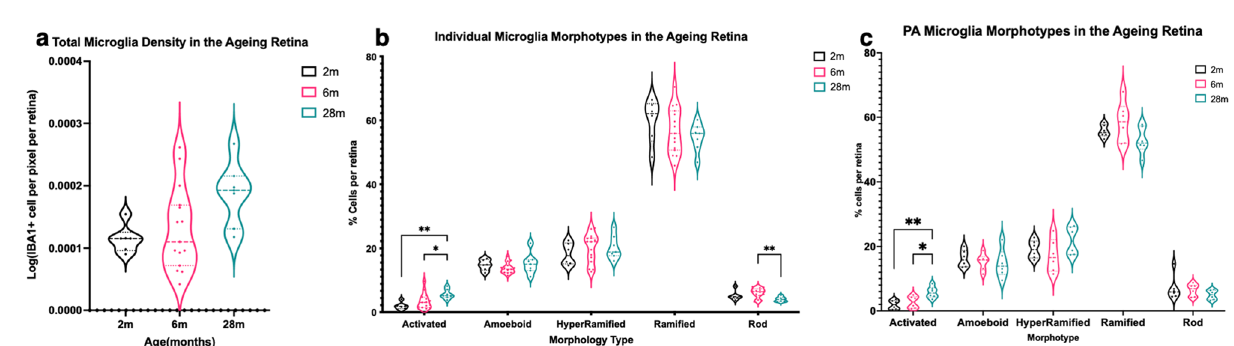
Figure 5. Retinal Microglia density graphs. ( a ) shows a graph of the total microglia density per pixel per retina with ageing. There were no significant differences between each age group (Kruskal Wallis). ( b ) shows a graph of the individual microglia morphotypes in the ageing retina. These were expressed as the percentage of each morphotype cells per retina. There were significant differences in the activated and rod microglia. ( c ) A graph of the PA microglia morphotypes in the ageing retina with the percentage of cells per retina for each morphotype. There were significant differences in the PA activated microglia with increasing age. (**p < 0.01, *p < 0.05, 2-way ANOVA with multiple comparisons). Black = 2 m; Pink = 6 m; Blue = 28